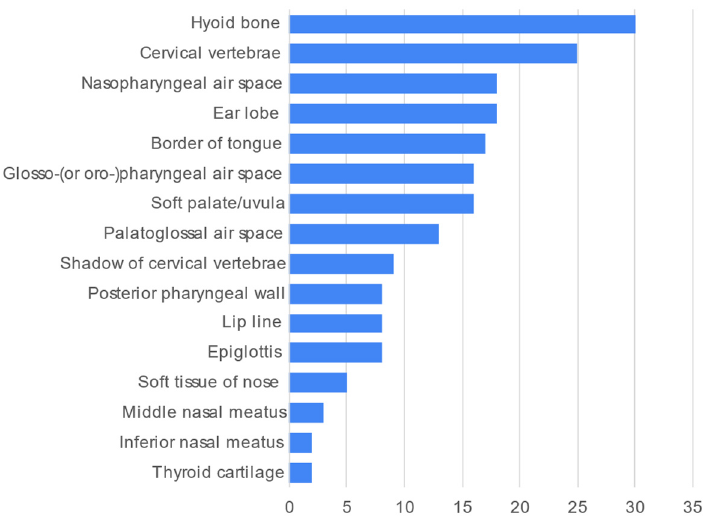
Figure 6. Frequency count of soft tissues/air spaces/other anatomical landmarks described in the 38 videos. Table 5. Pearson correlation between the viewing